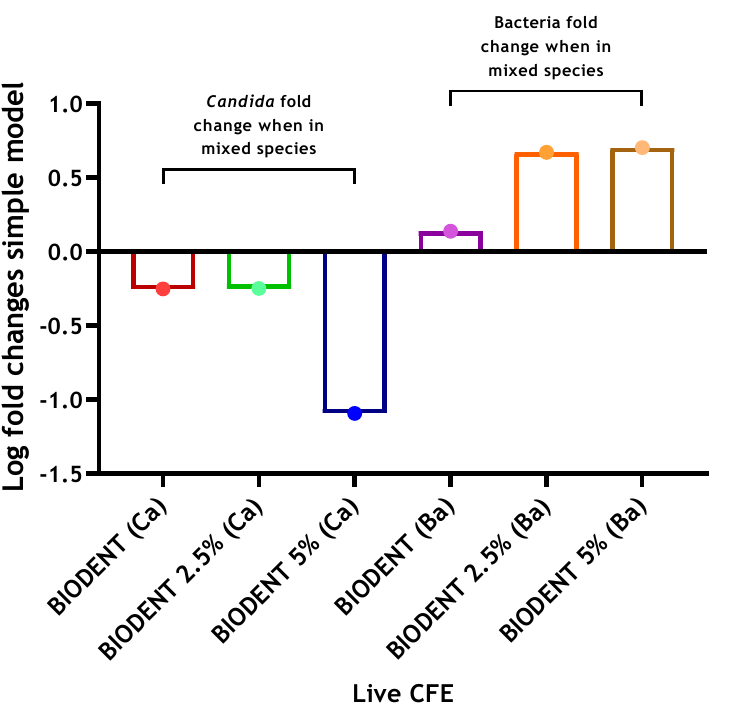
Figure 5. Log fold changes of live yeast and bacteria in complex 4-species biofilm model on Biodentine discs ± chitosan. C. albicans and bacteria were quantified (CFE/mL) in mixed-species biofilms (4 species) and compared to simpler models of C. albicans- only biofilms (1 species) and bacterial-only biofilms (3 species), respectively. Log fold changes were calculated and presented graphically. Data representative from three repeats with 3 technical replicates.